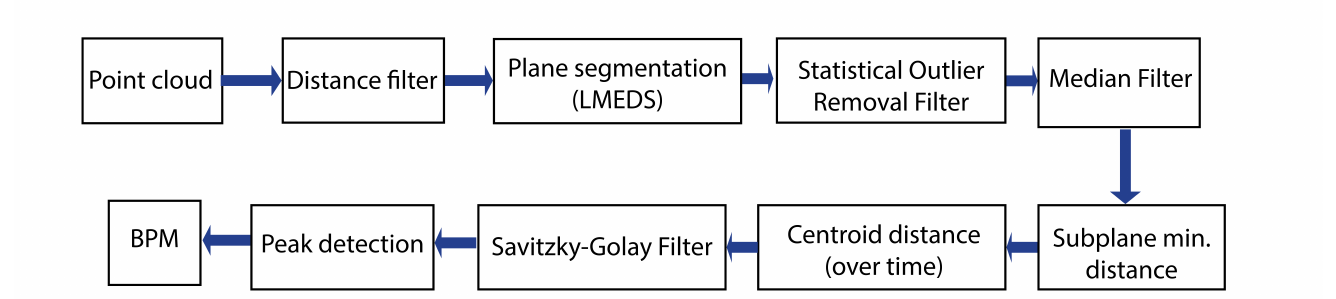
Figure 6. Signal processing for the respiratory rate detection using the ToF camera.